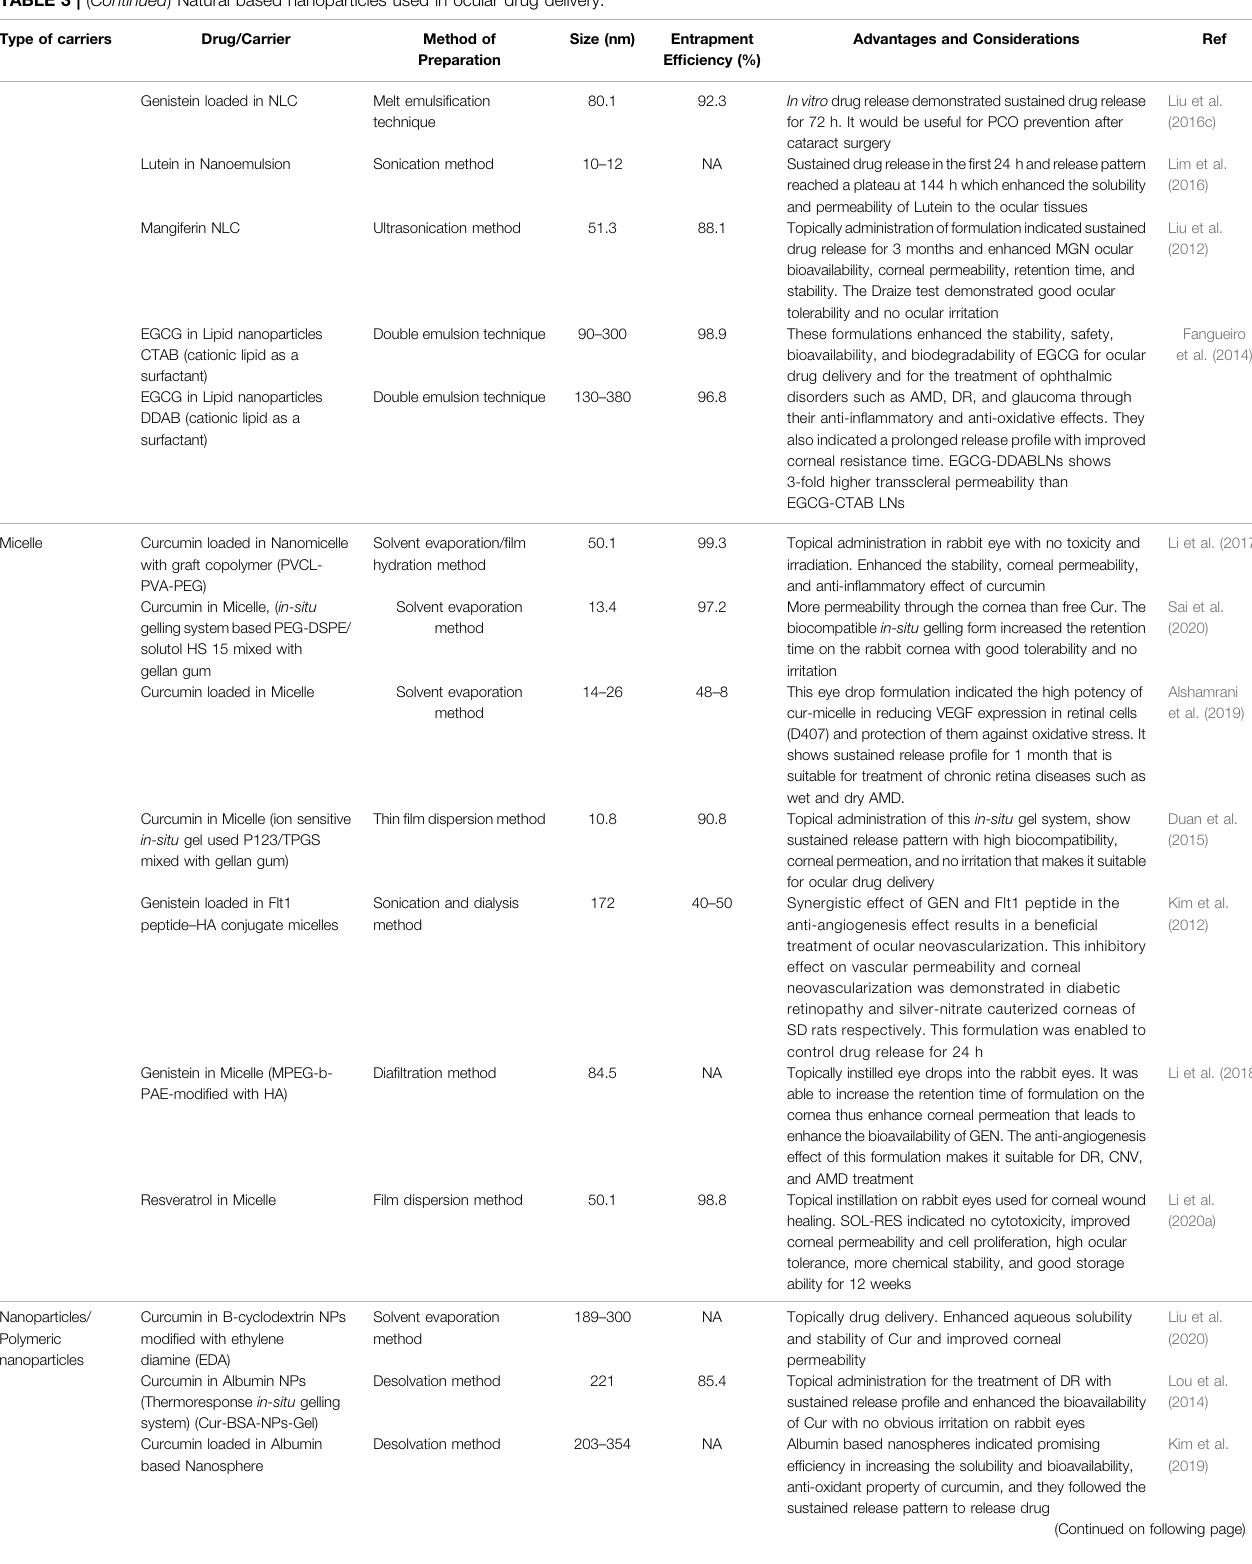
TABLE 3 | ( Continued ) Natural based nanoparticles used in ocular drug